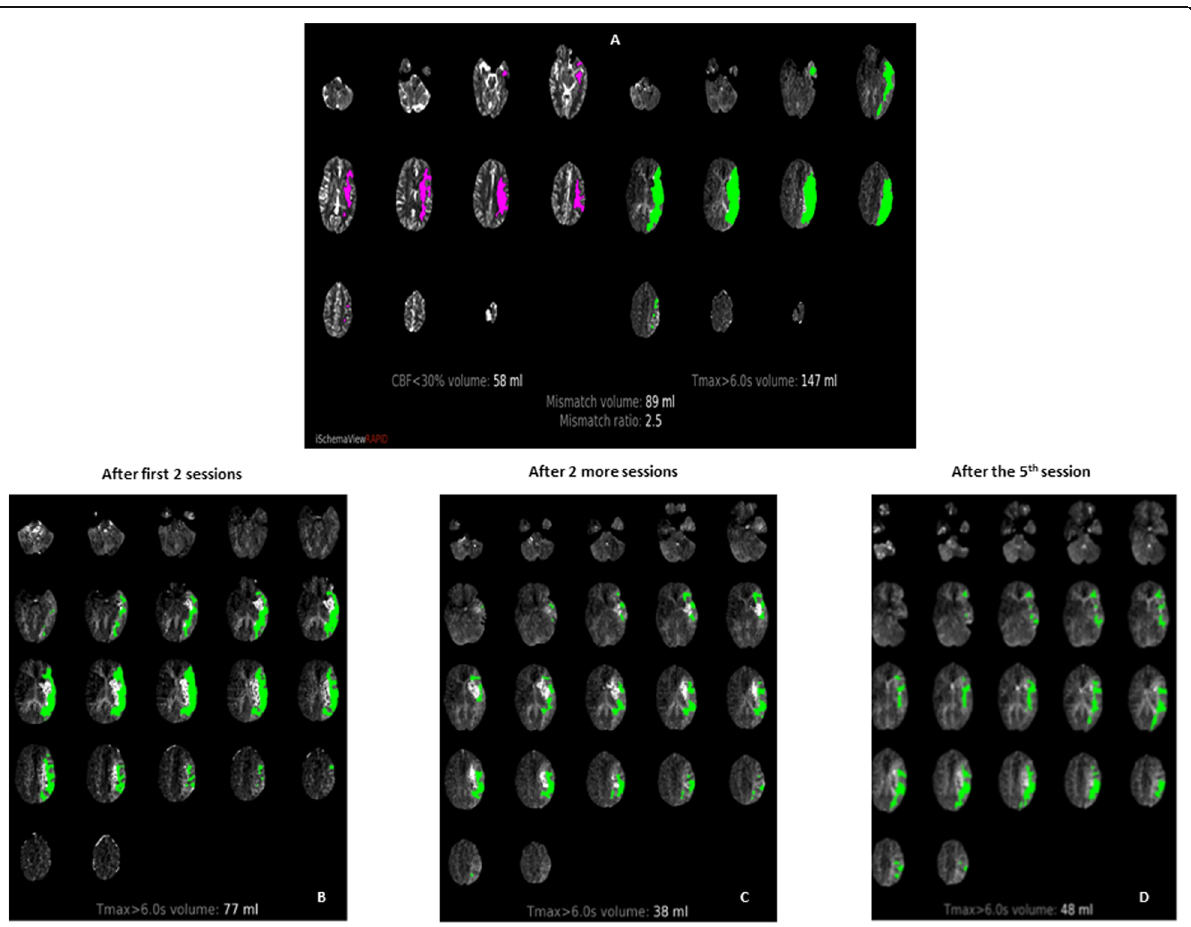
Fig. 3 CT perfusion: serial computed tomography-perfusion studies over 2 weeks using the RAPID software. a The initial CT-perfusion on presentation showing a core infarction of 58 ml, ischemia of 147 ml, mismatch volume of 89 ml and mismatch ratio of 2.5. b – d Follow-up CT- perfusion studies after starting hyperbaric oxygen therapy (HBOT) presented in order showing ischemia reduction ( b 77 ml, c 38 ml, and d 48 ml). Although there is a slight increase in the penumbra after the fifth session of HBOT, a clear trend of penumbra reduction is seen through the follow-up studies compared to the initial study. Although the amount of clinical improvement is less than the radiological improvement, the relatively large core infarction and its location might be the determinant of that perfusion/clinical mismatched